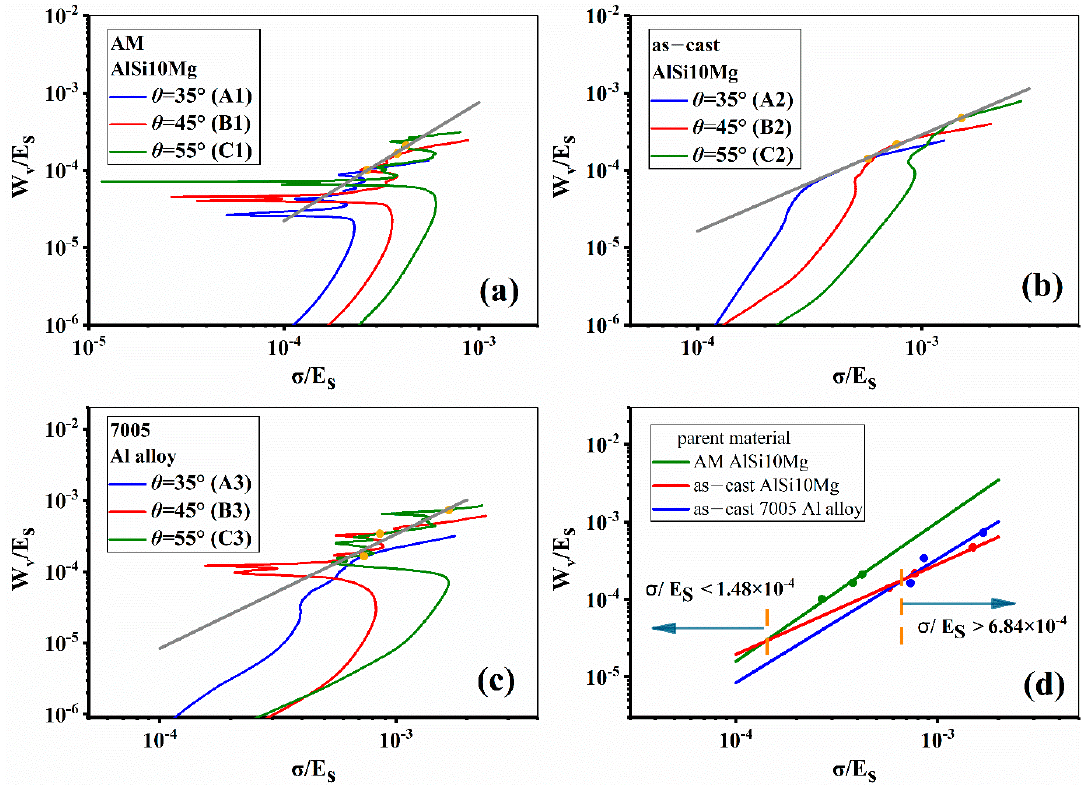
Figure 13. Energy absorption diagrams of samples with different strut materials and inclination angles; ( a – c ) represent the results of AM AlSi10Mg, as–cast AlSi10Mg and 7005 Al alloy, respectively; ( d ) is the summary of above results.